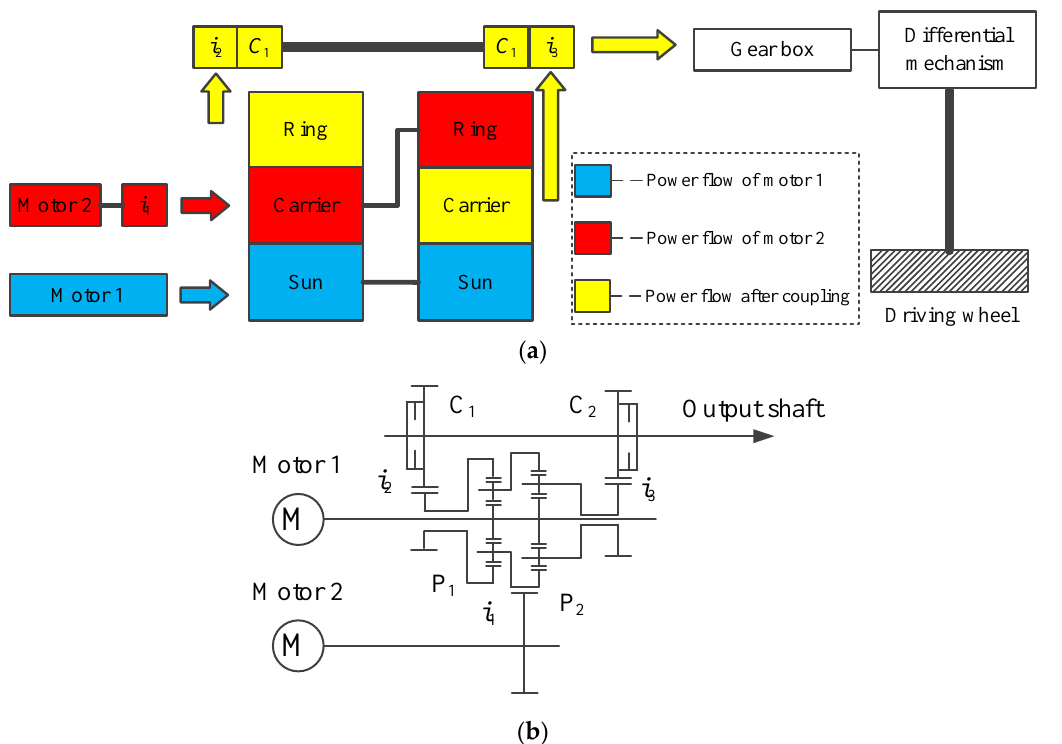
Figure 1. The new drive system proposed in this paper: ( a ) power transmitting route and ( b ) transmission scheme.